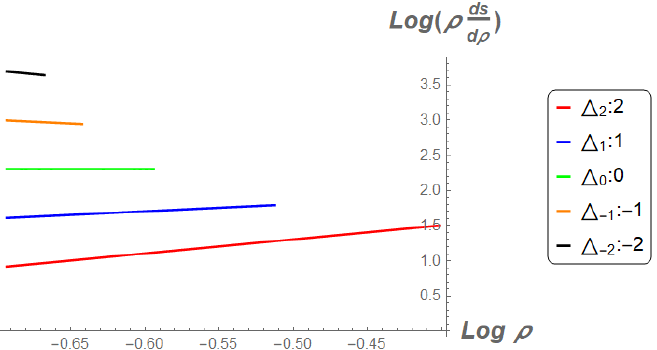
Figure 9. The Curvature and its derivative in the minimum principal direction of LoCs on LA swept surfaces. ( a ) Curvature, 𝜅 , ( b ) Derivative of Curvature, 𝜅′ .